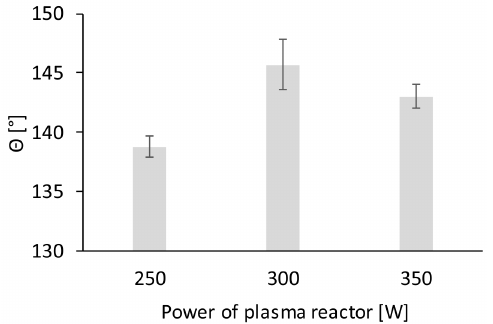
Figure 3. Water contact angle vs. plasma power on the PS surface with smooth pore borders with one cycle of plasma treatment. The smooth borders were prepared using five doses in 1.5 THF:8.5 ETH at 295 K.